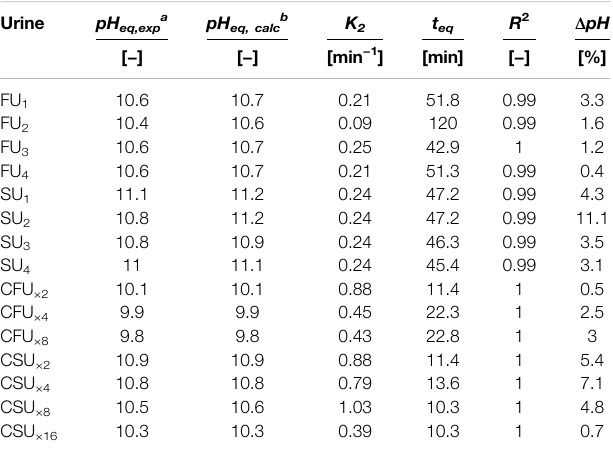
TABLE 2 | Dissolution kinetics of Mg(OH) 2 in real fresh urine (FU), synthetic fresh urine (SU), concentrated fresh urine (CFU) and concentrated fresh synthetic urine (CSU).